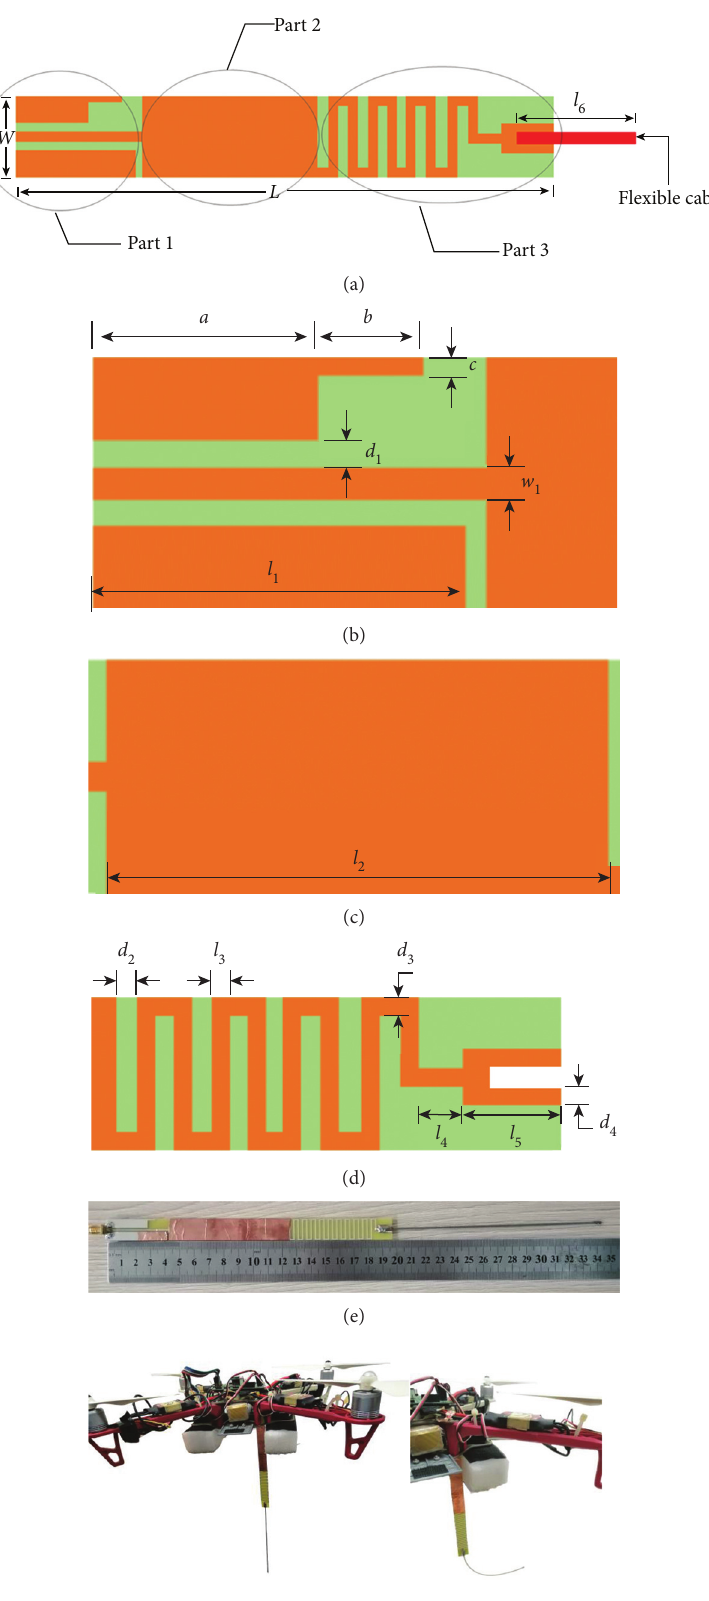
Figure 1: Geometry of the proposed antenna. (a–e) Detailed dimensions of the antenna (top view). (b) Part 1, (c) part 2, (d) part 3, and (f) the flexibility of antenna